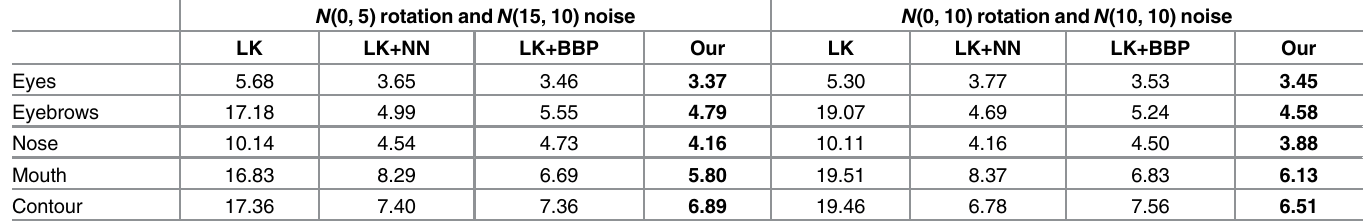
Table 1. The RMSE results for each facial component by different methods.